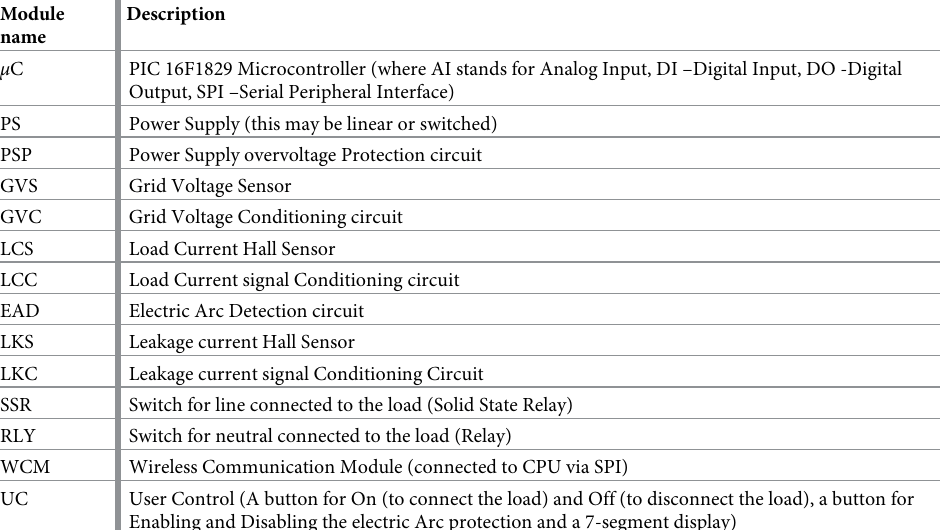
Table 1. Internal modules